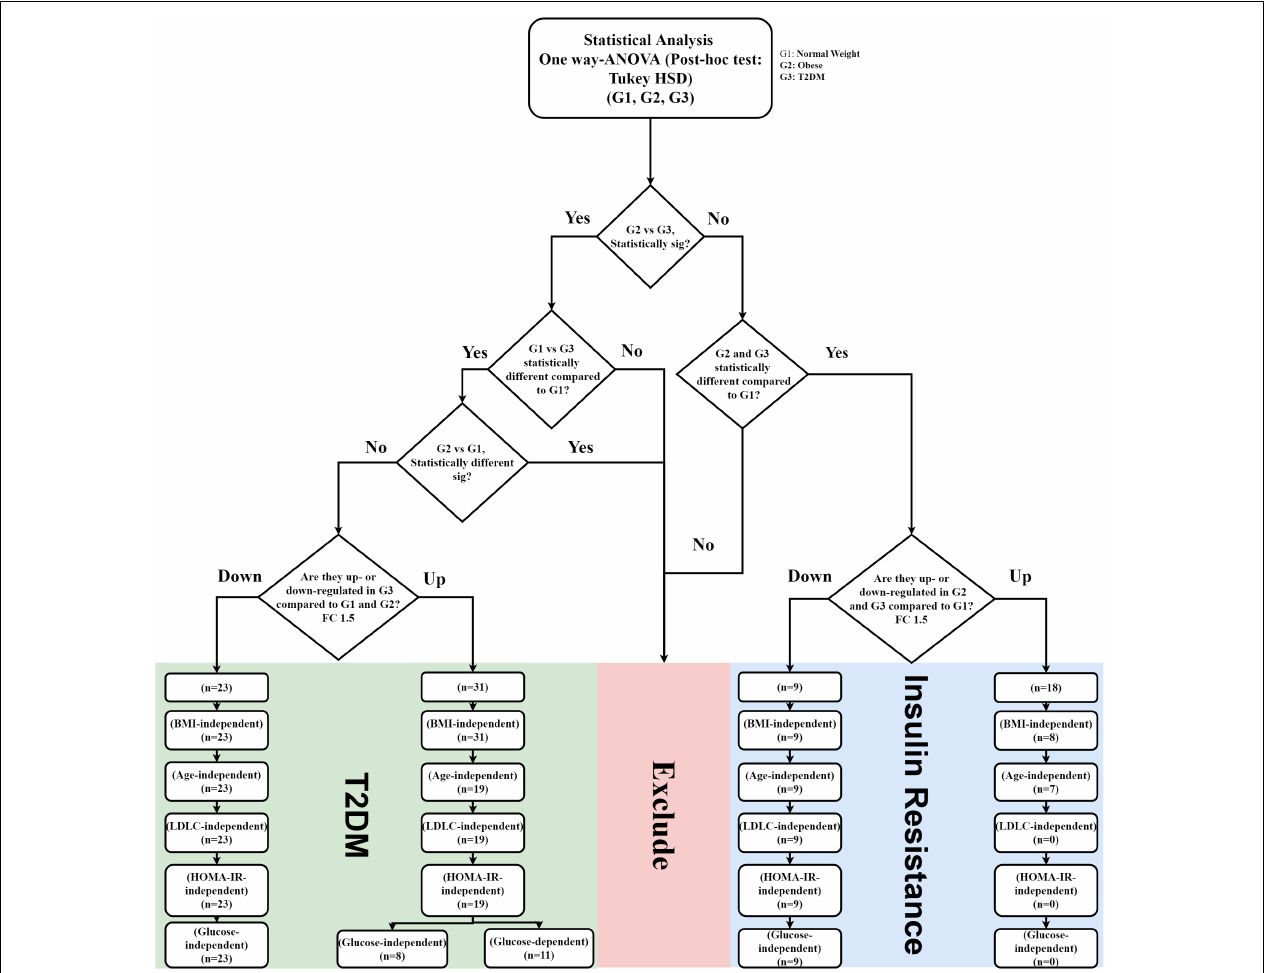
FIGURE 4 | IR and T2DM metabolic panel data mining scheme. IR metabolic model was generated based on the fold change difference (FC cutoff 1.5) and statistically significant features between lean vs obese and lean vs T2D, and insignificance between obese vs T2D (FDR-corrected p -value < 0.05; n = 27 metabolites; 18 up-regulated, and nine down-regulated) T2DM metabolic panels were built based on fold change (FC cutoff 1.5), and statistical significance between lean and T2DM, and obese and T2DM, and insignificance between lean and obese (FDR-corrected p -value < 0.05) ( n = 54 metabolites: 31 were up-regulated, and 23 down-regulated). These panels underwent several filtration stages to exclude BMI, age, and LDL-C effects. Eventually, the remaining metabolites in each panel were correlated with HOMA-IR and glucose